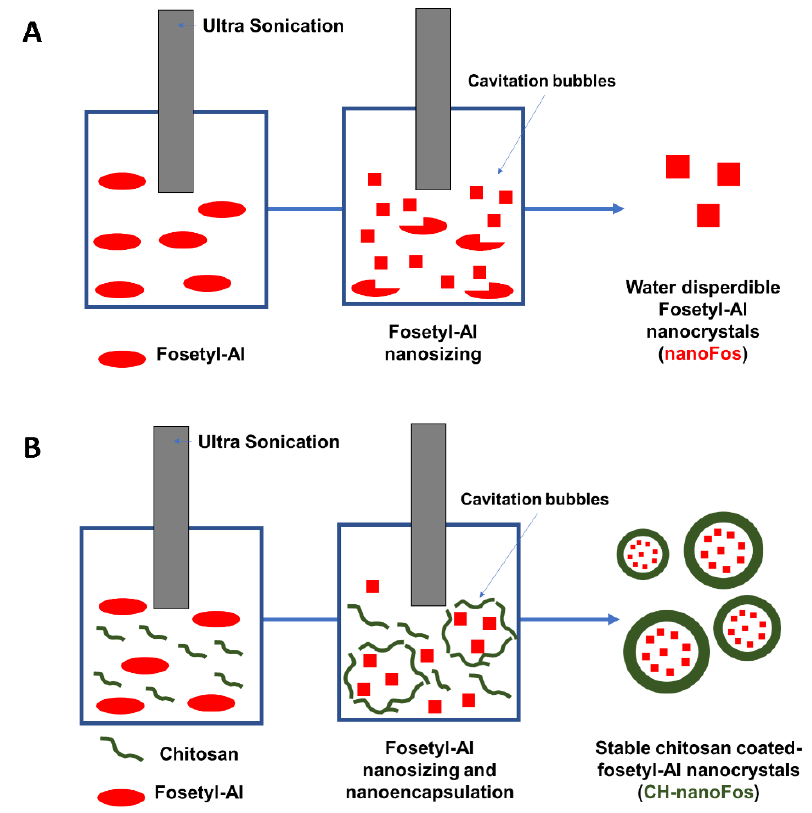
Figure 1. Scheme of ultrasonication-assisted production of fosetyl-Al nanocrystals (nanoFos) ( A ) and chitosan-based fosetyl-Al nanocrystals (CH-nanoFos) ( B ).